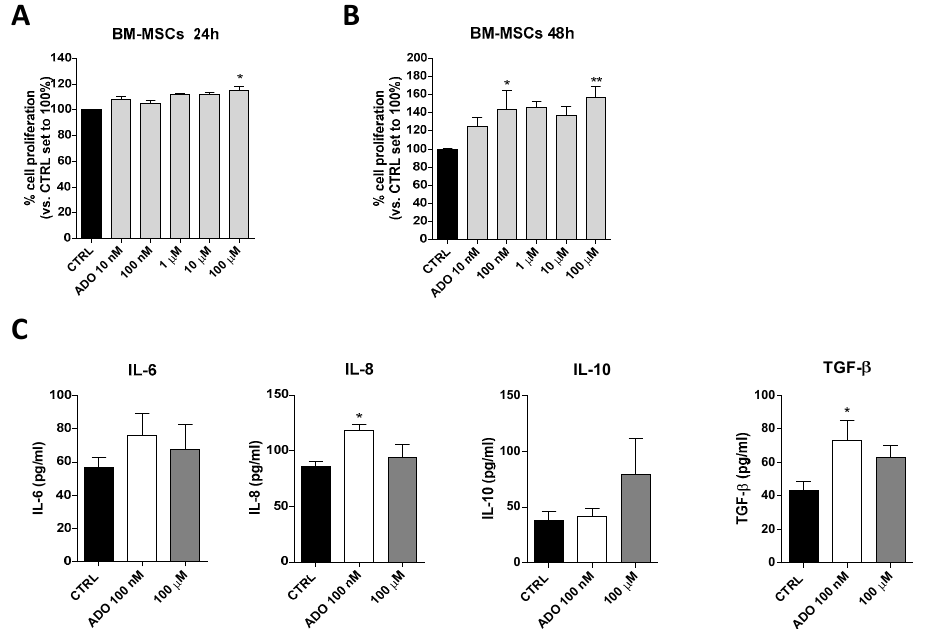
Figure 4. ADO e ff ects on BM-MSCs proliferation and BM-MSCs cytokines release. ( A , B ) BM-MSCs were treated with di ff erent concentrations of ADO (10 nM to 100 µ M) for 24 h ( A ) or 48 h ( B ) in complete medium. At the end of the treatment period, cell proliferation was evaluated as described in Section 4.3. The data are expressed as percentage relative to untreated cells (CTRL), which were set at 100% (mean ± SEM; N = 3). ( C ) BM-MSCs were treated in serum-free medium with ADO (100 nM and 100 µ M) for 48 h. At the end of treatment, the IL-6, IL-8, IL-10 and TGF- β levels in the medium were quantified using commercial ELISA kits. The data are reported as the mean values ± SEM of three independent experiments. The significance of the di ff erences was determined by one-way ANOVA, followed by Bonferroni’s post-hoc test: * p < 0.05, ** p < 0.01 vs. the CTRL.